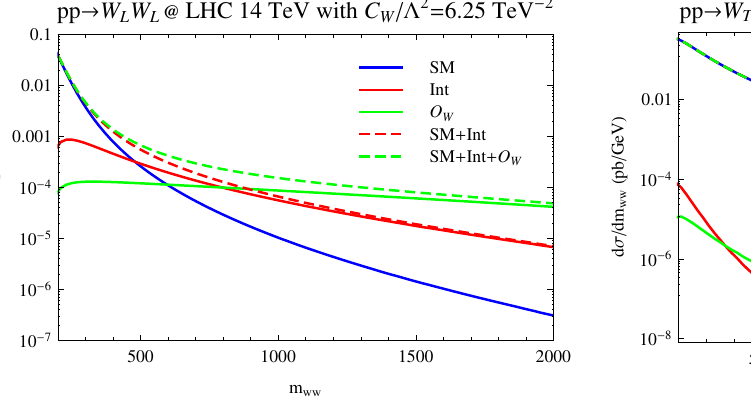
Figure 2. Invariant mass distributions for the production of two longitudinally polarized W bosons for the SM (Solid blue line), for the interference between the SM and O W (Solid red line), for O W squared amplitude (Solid green line), for the sum of the SM and its interference with the dimension-six operator (Dashed red line) and for the sum of all the contributions (Dashed green line).